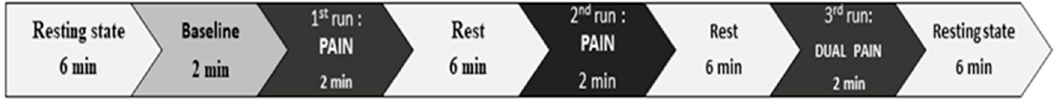
Figure 1. The study design.